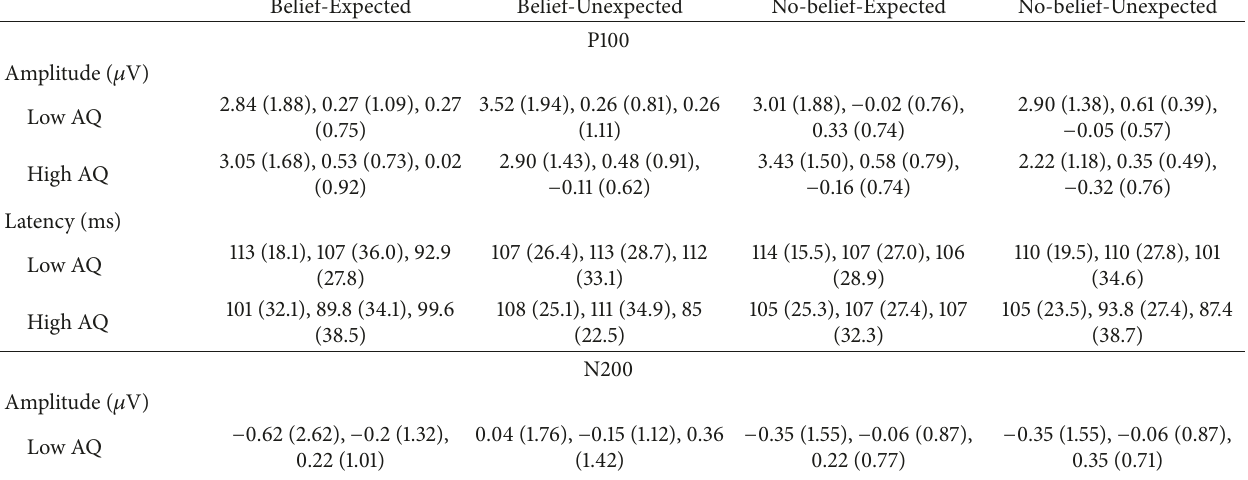
Table 2: Mean ERP amplitudes ( 𝜇 V) and latencies (ms) on 𝑃𝑧 , 𝐶𝑧 , and 𝐹𝑧 (standard deviants in parentheses). Belief-Expected Belief-Unexpected No-belief-Expected